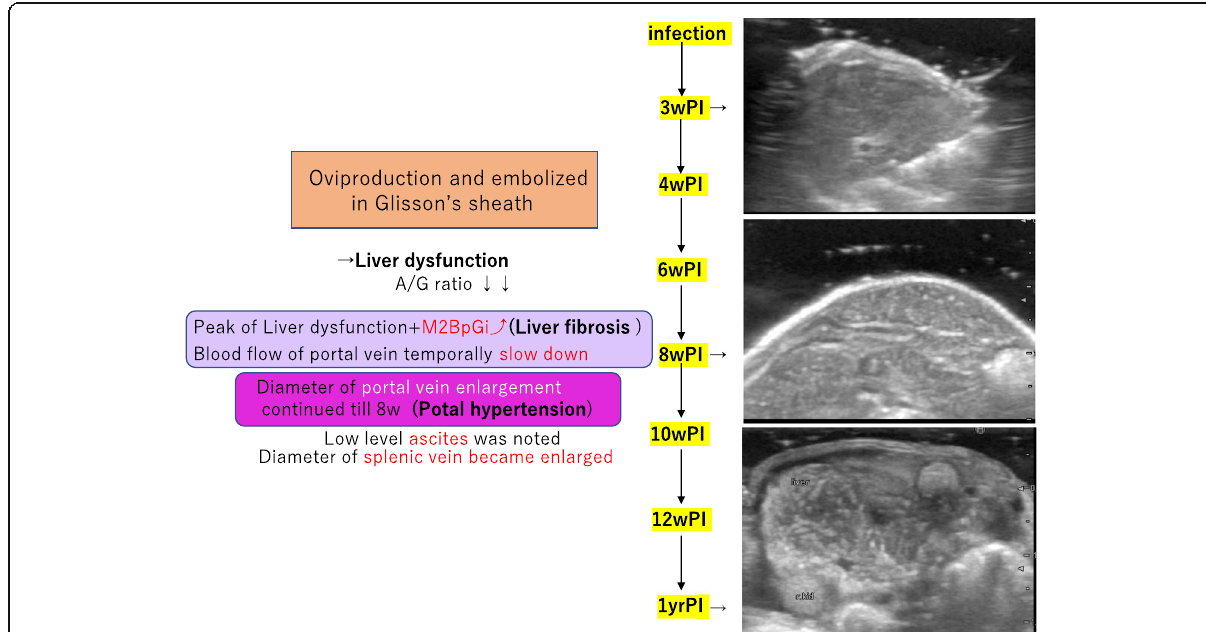
Fig. 10 Time course of an experimental mouse model of S. japonicum infection . We were able to capture the progression of hepatic parenchyma abnormalities, secondary liver fibrosis, and portal hypertension over time with the support of blood